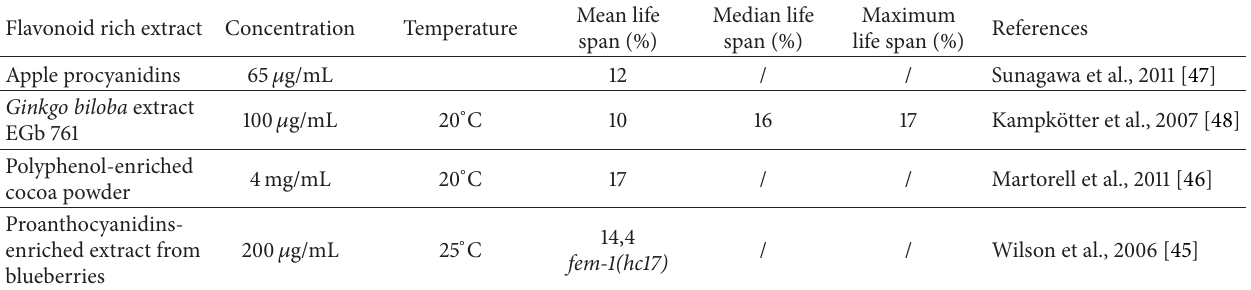
Table 2: Modulation of the mean, median, and maximum life span of C. elegans by flavonoid rich plant extracts in different studies. Flavonoid rich extract